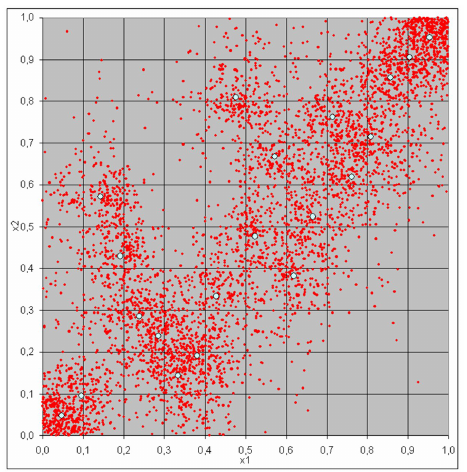
Figure 30: Power copula with LF copula driver, Figure 31: Power copula with LF copula